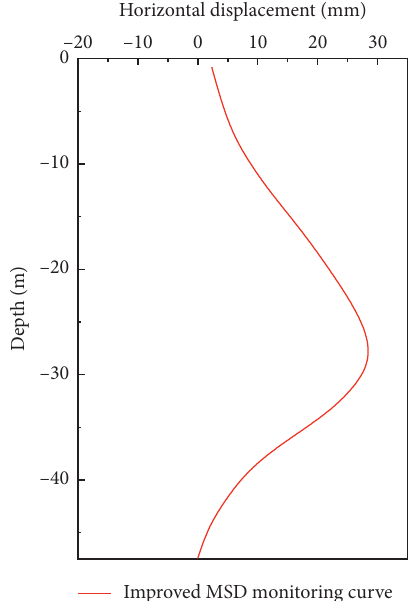
Figure 9: Deformation superposition of continuous wall.